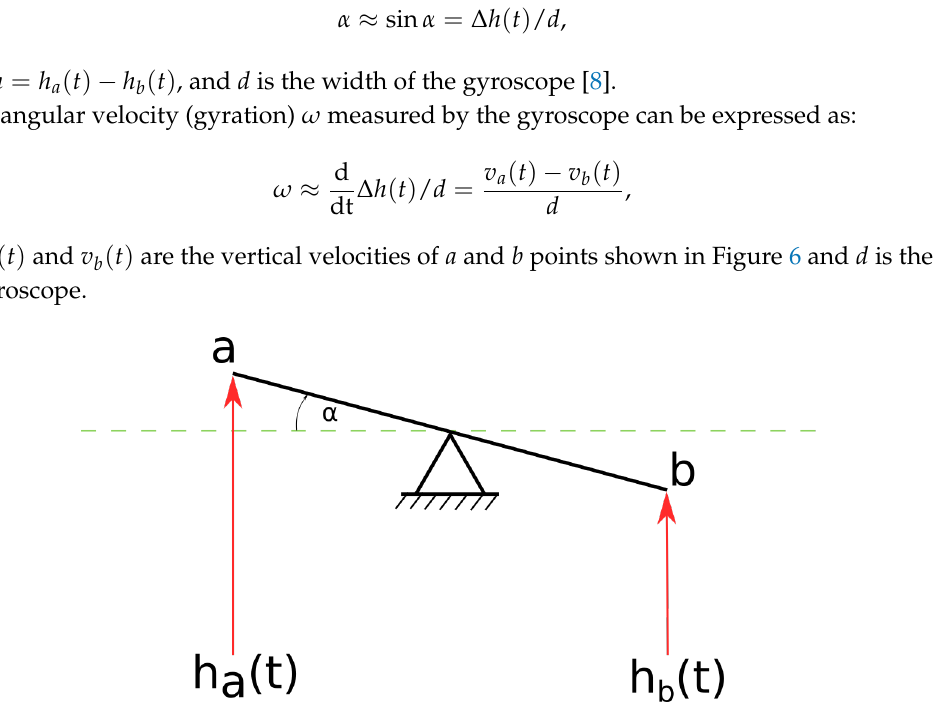
Figure 6. The model of the relationship between the rotation of the horizontal plane α and angular velocity ω